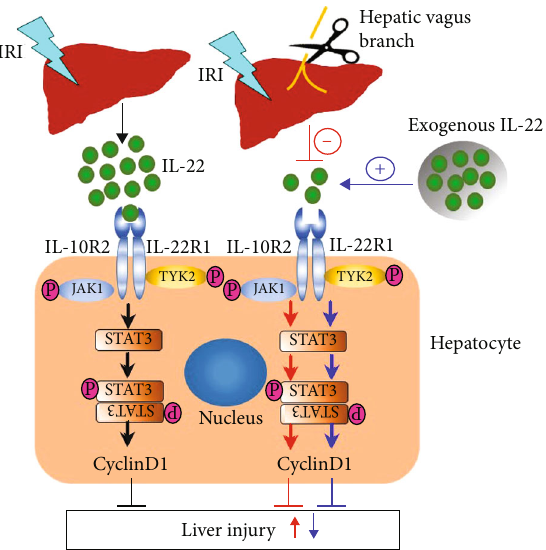
Figure 7: Schematic representation depicting the potential mechanisms of Hv (hepatic vagotomy) aggravating hepatic ischemia-reperfusion injury. Expression of IL-22 induced by IR injury in the liver was signi fi cantly downregulated when the hepatic vagus branch was cut o ff . Following this, the activation of STAT3 signaling pathway is downregulated, and then the expression of cyclin D1 is downregulated, which eventually aggravates liver injury. In mice treated with exogenous IL-22, the aggravating e ff ect of Hv on liver injury was reversed due to the IL-22